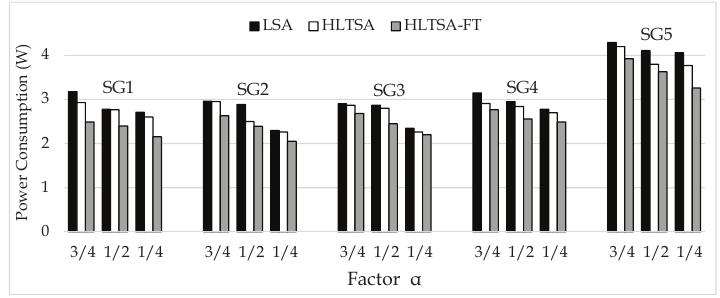
Figure 7. Comparison of average power consumption under different heuristics (SG1–SG5).